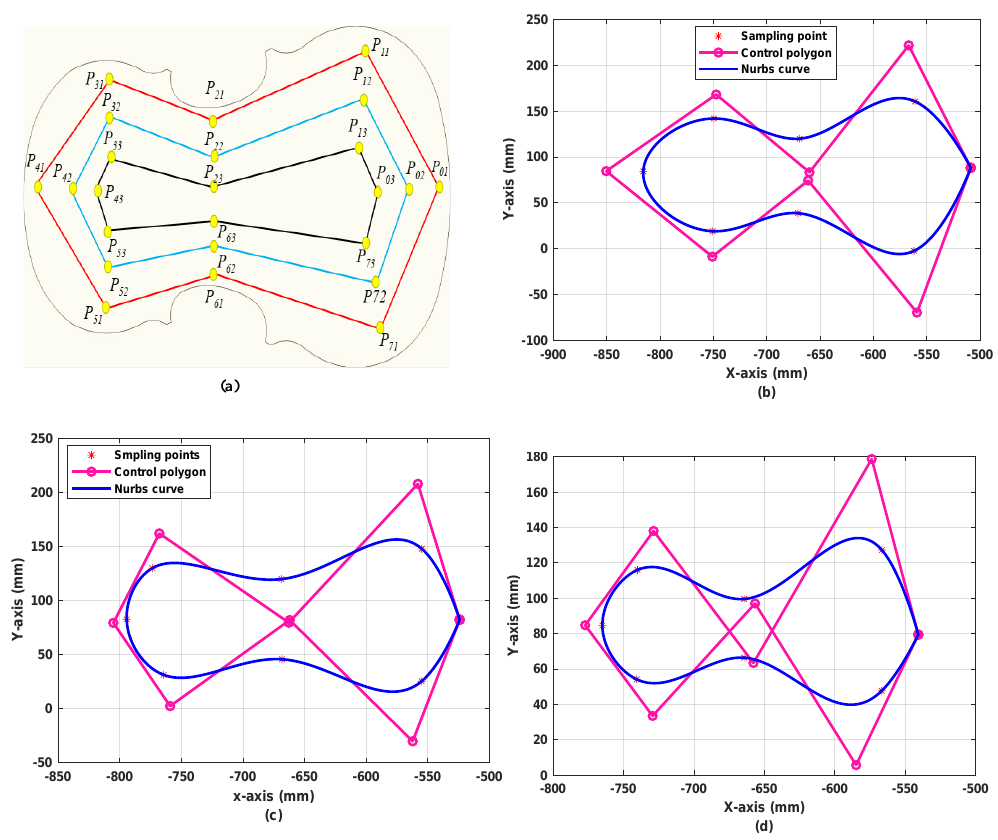
Figure 10. The polishing paths ( a ) control points on work-piece ( b ) path1 , ( c ) path 2 and ( d ) path3. Table 1. The control points (mm) on the violin